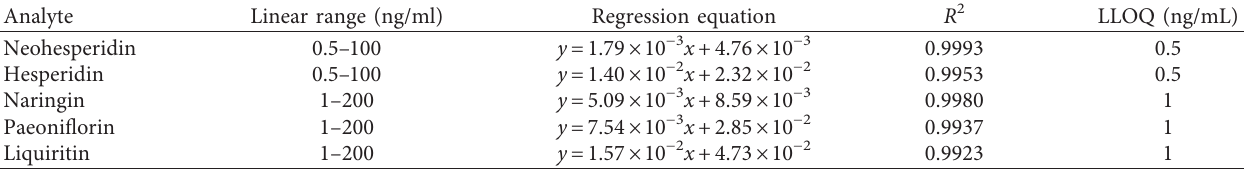
Table 5: The typical regression equations, correlation coefficient, and LLOQ in beagle plasma determined by HPLC-MS/MS. Analyte